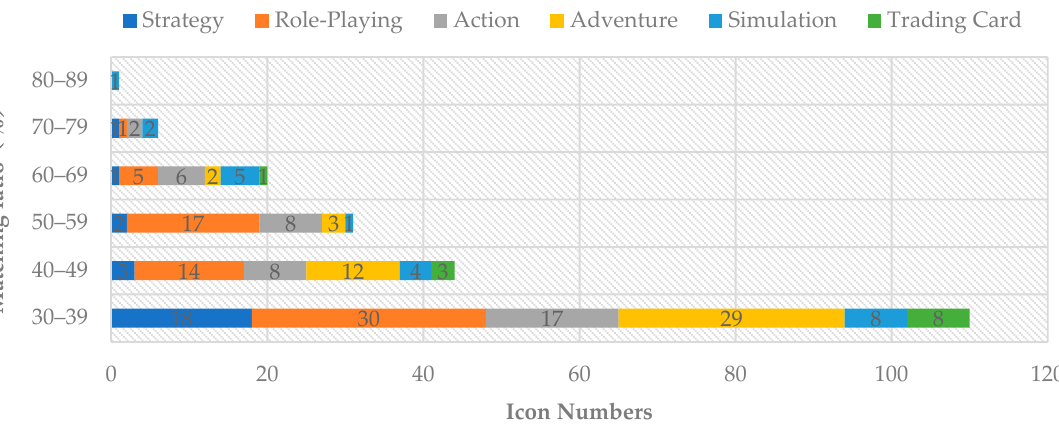
Figure 3. Highly matched icon distribution.